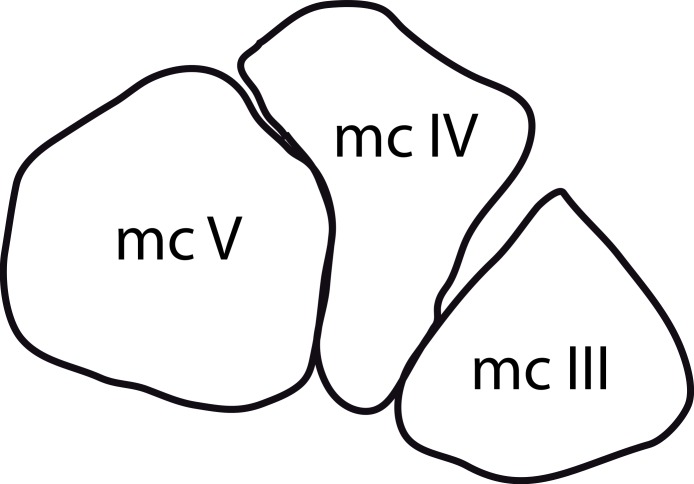
Metacarpals III–V of Apatosaurus louisae CM 3018.Articulated metacarpals III–V of Apatosaurus louisae CM 3018 in proximal view (traced from Gilmore, 1936), showing the greatly enlarged mc V, in comparison to mc III and IV (C403-1).